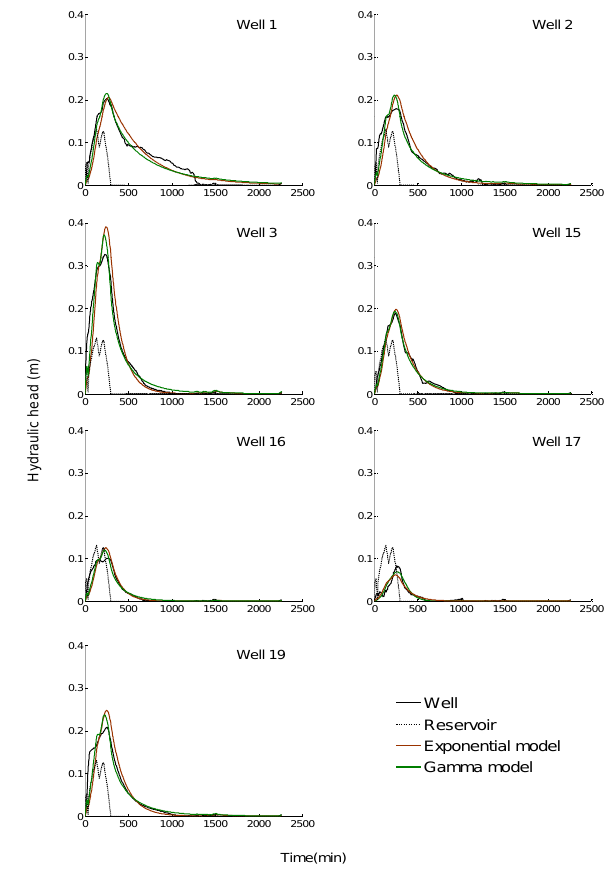
Fig. 5. Optimized models of pressure transport for no-salt test. Fig. 6. Optimized models of pressure transport for salt-added test.